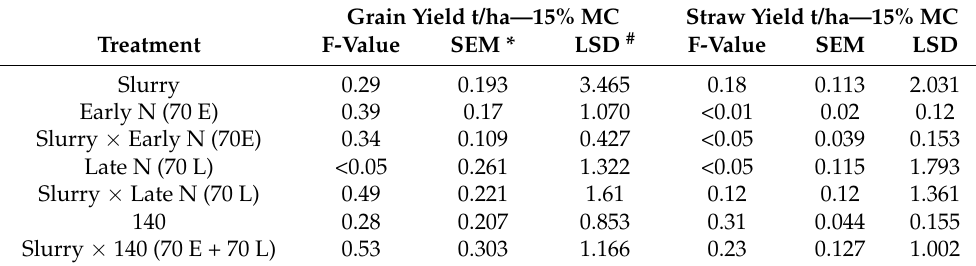
Table 6. ANOVA analysis of 2017/18 spring barley grain and straw yields (t/ha).